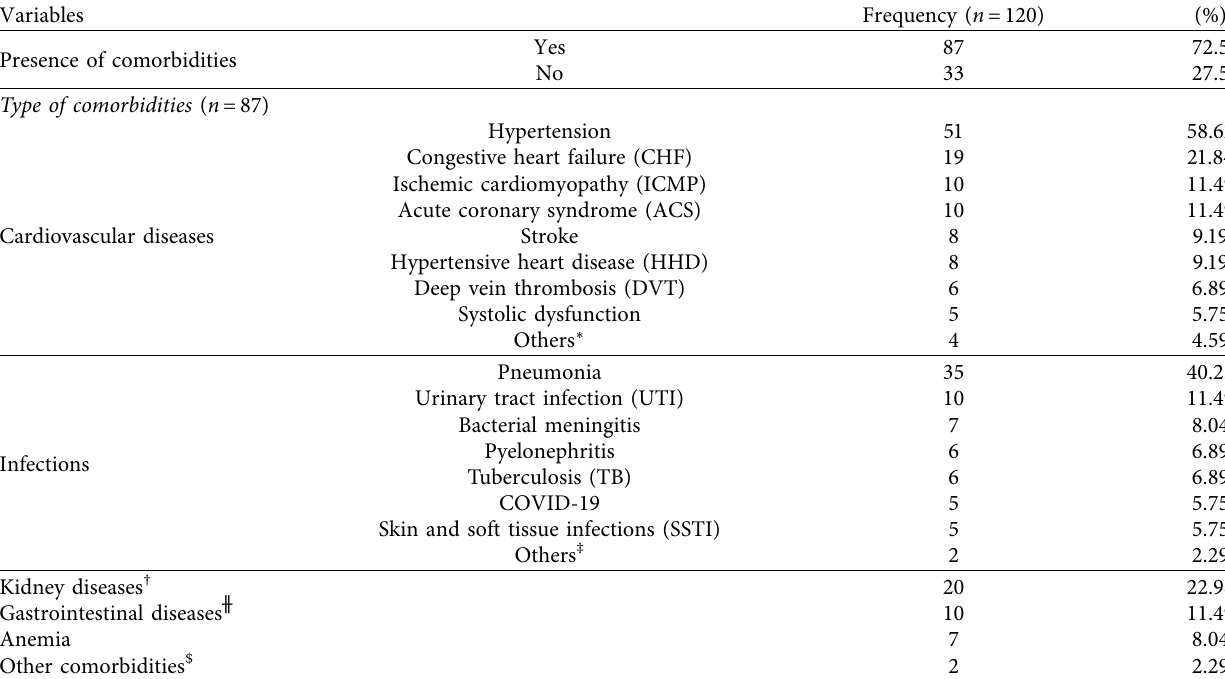
Table 3: Prevalence of comorbidities among patients with DM admitted to JMC from October 01, 2020, to June 30, 2021. Variables Frequency ( n � 120) Presence of comorbidities